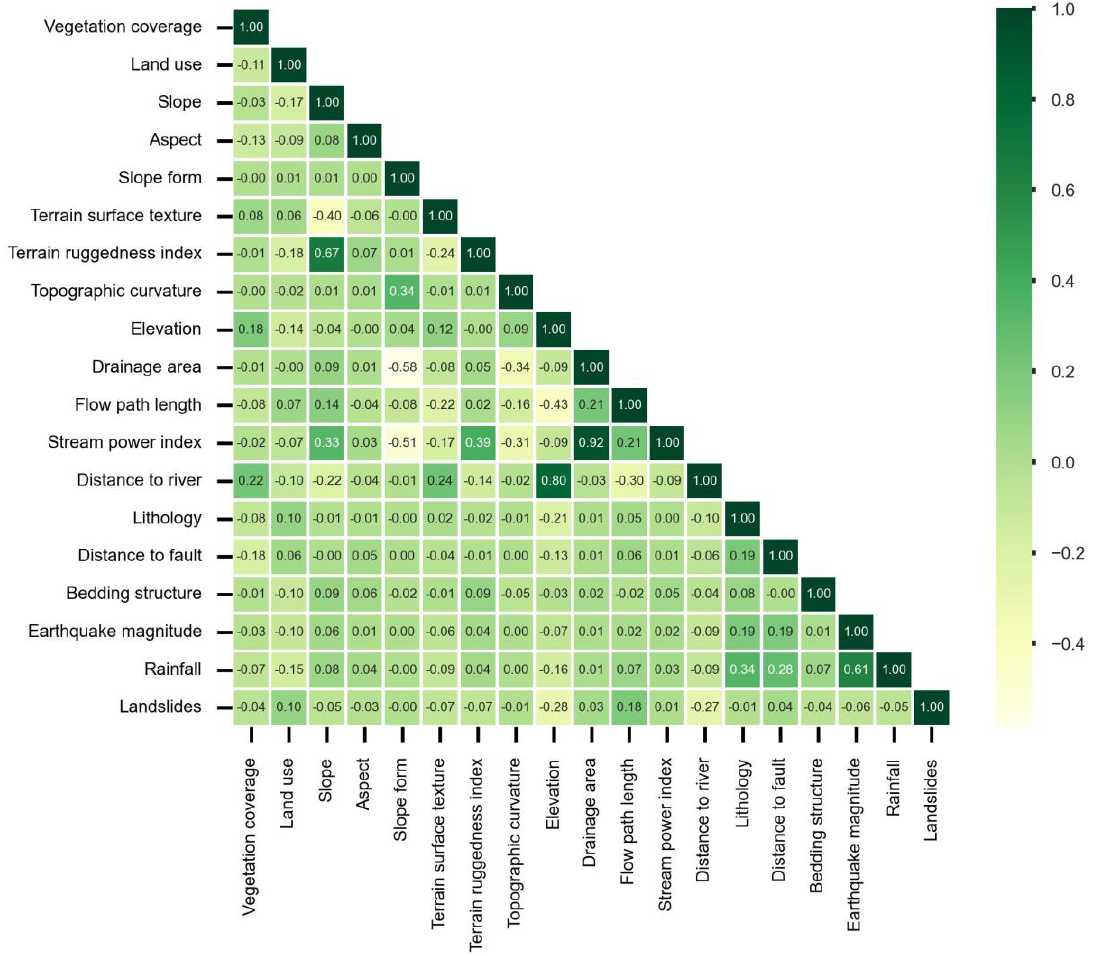
Figure 9. SRCC between landslide influence factors and the landslides.